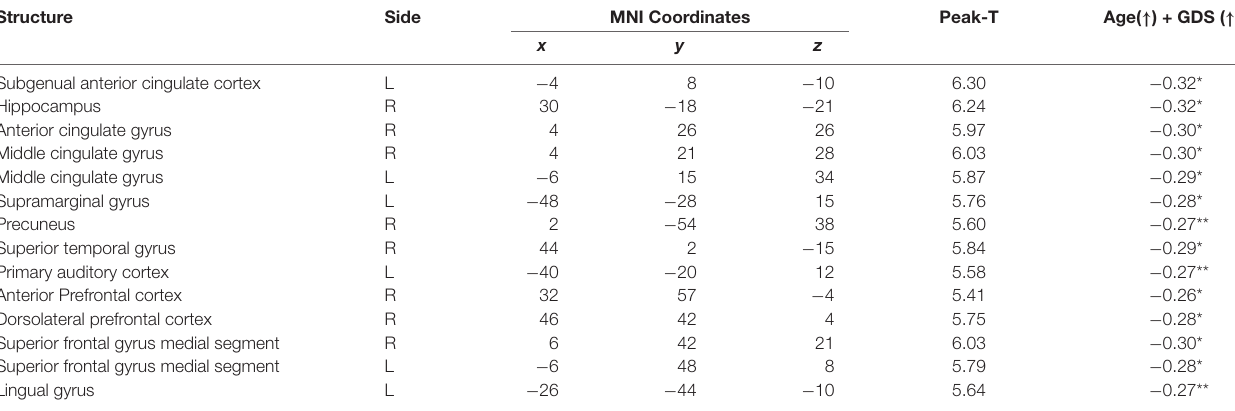
TABLE 7 | Correlations between age, depression, and ROIs. Structure Side MNI